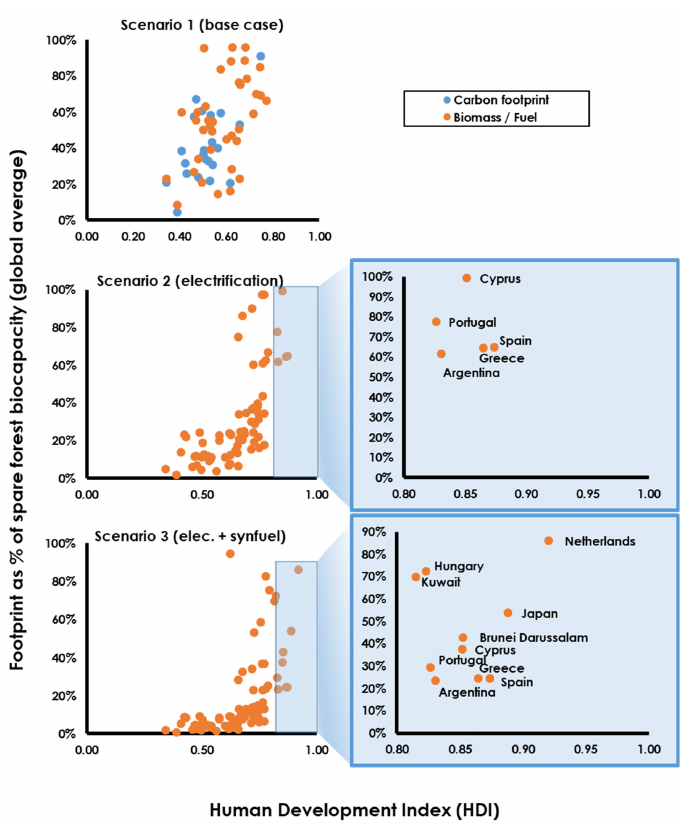
Figure 8. Required appropriation of forest area (based on a global average) for energy and carbon versus Human Development Index for countries.